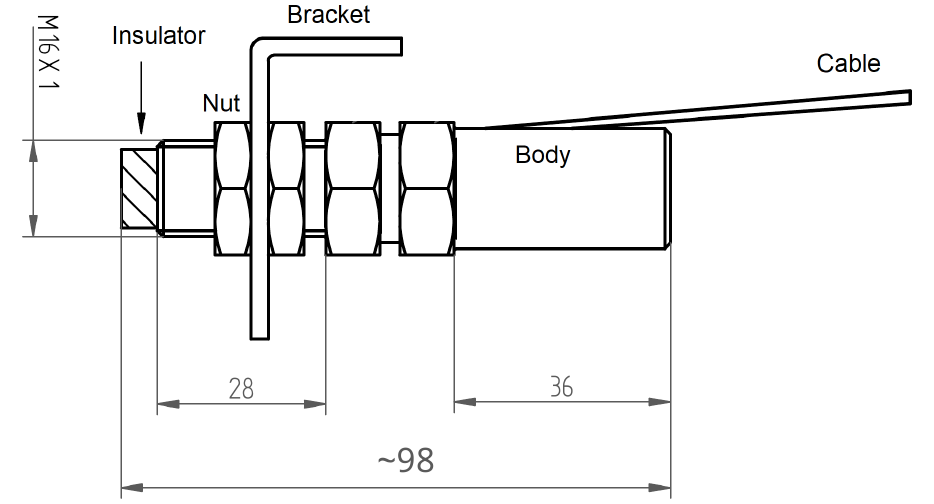
Figure 3. Inductive sensor with a mounting